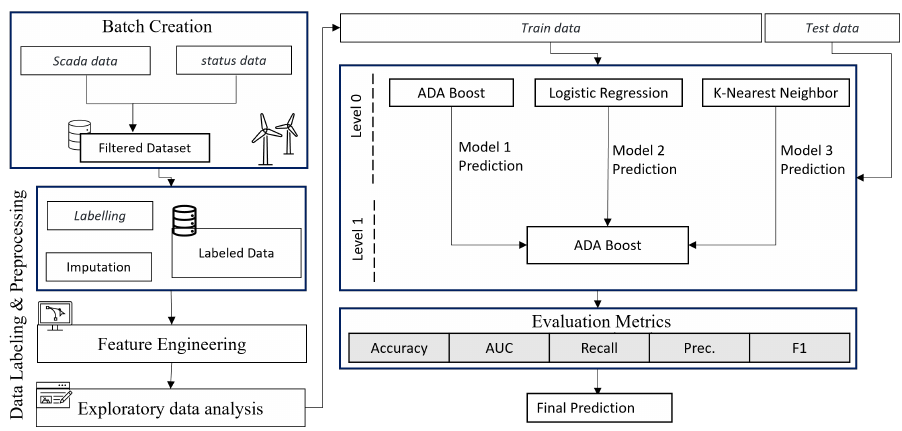
Figure 3. Structure of the proposed